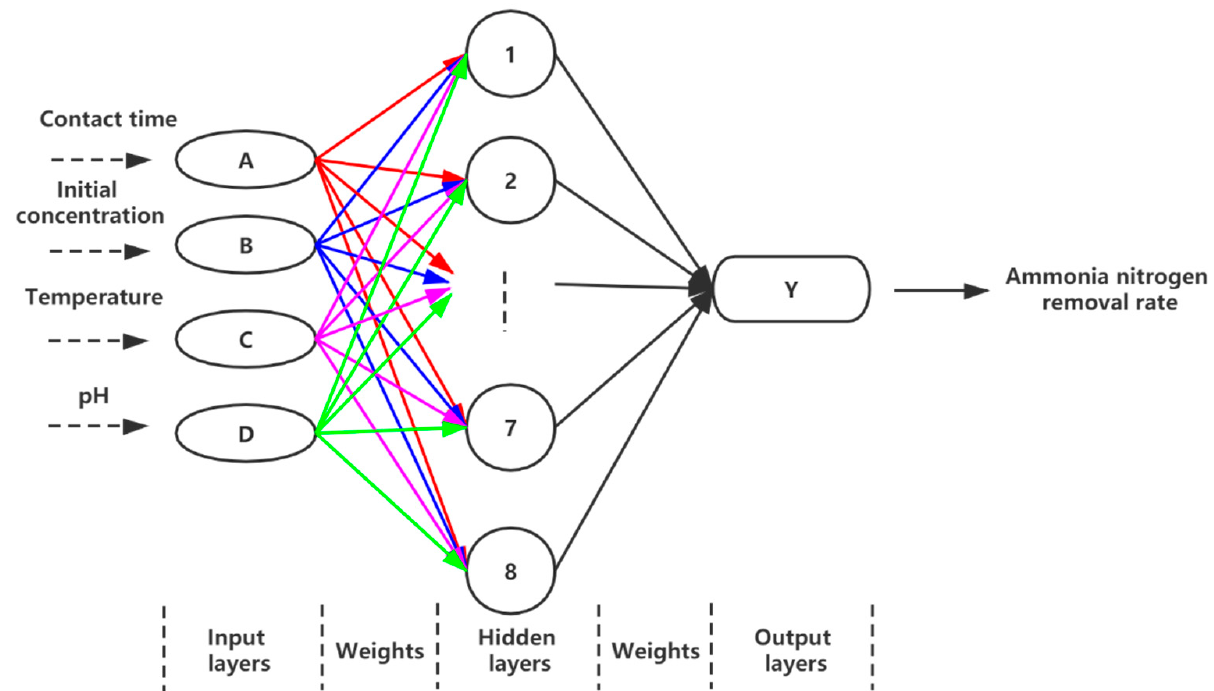
Table 2. Experimental ranges and levels of variables.